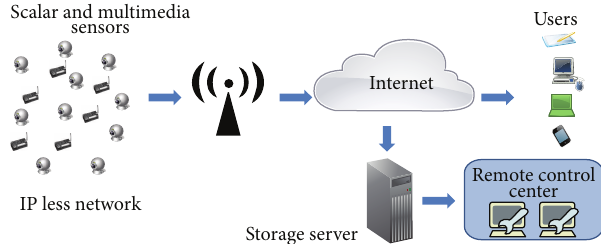
Figure 7: WMSNs architecture for